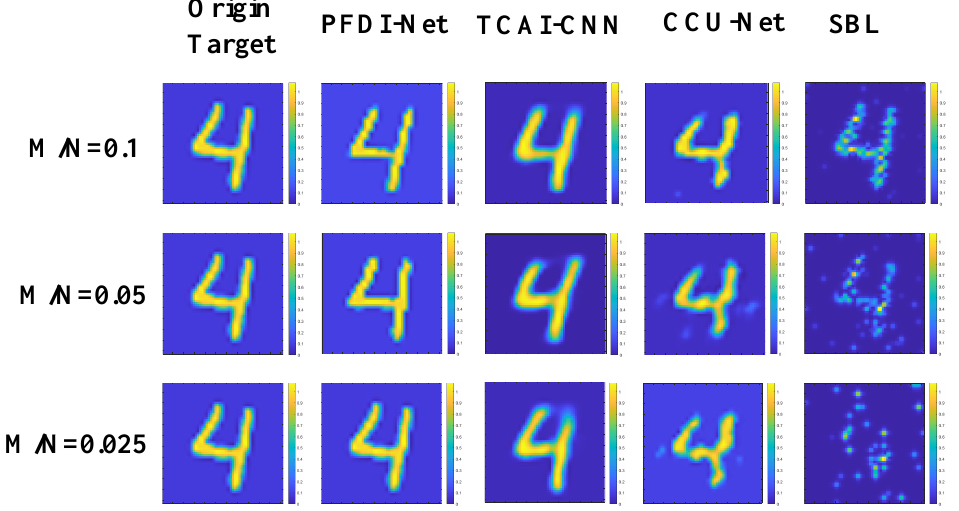
Figure 5. PFDI-MNIST: Reconstruction results in four imaging algorithm with different scene infor- mation sampling